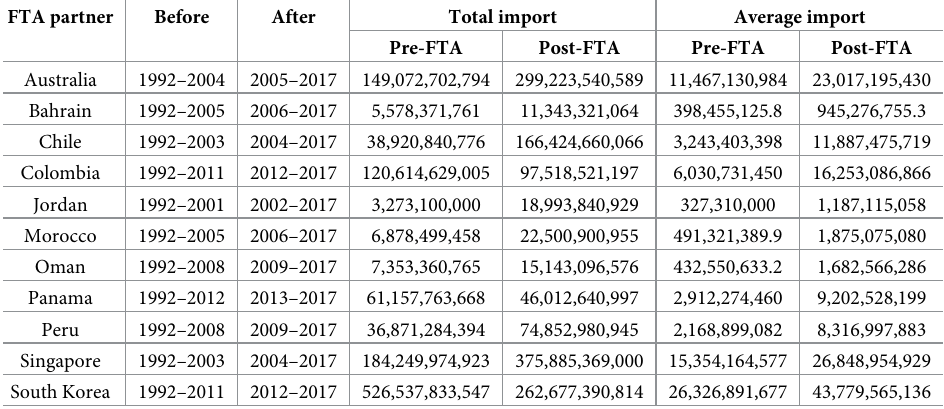
Table 7. Bilateral U.S imports from trade partners before and after FTAs entered into